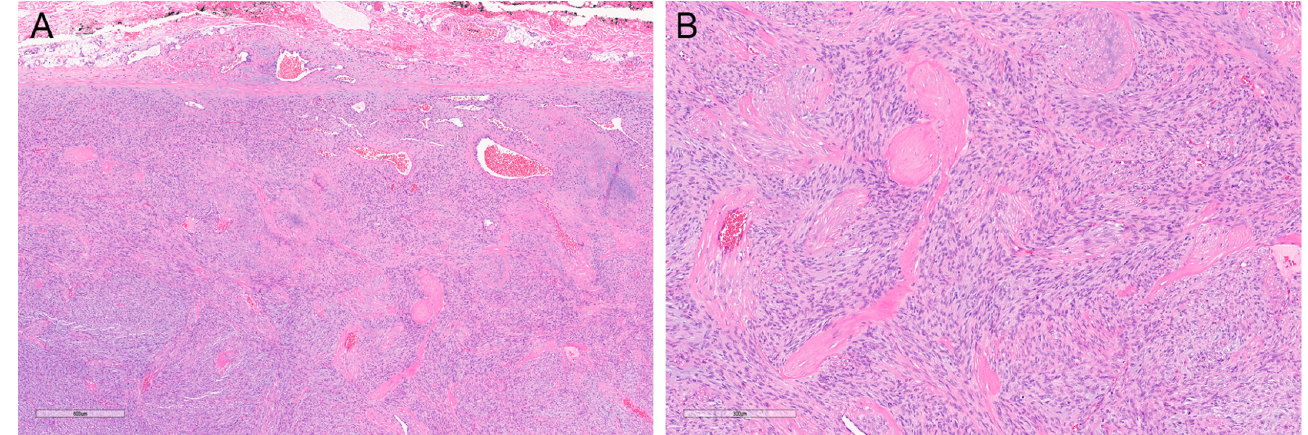
Figure 4. Myoid DFSP. Stromal vessels can have myointimal hyperplasia resulting in myoid nodules (( A ); magnification ×40), which is not a usual feature in conventional DFSP—more common in DFSP with fibrosarcomatous transformation. The cell myoid nodules have more abundant bright eosinophilic cytoplasm with cigar-shaped nuclei—catachrestic of smooth muscle differentiation with SMA expression (( B ); magnification ×100). They are positive for SMA.